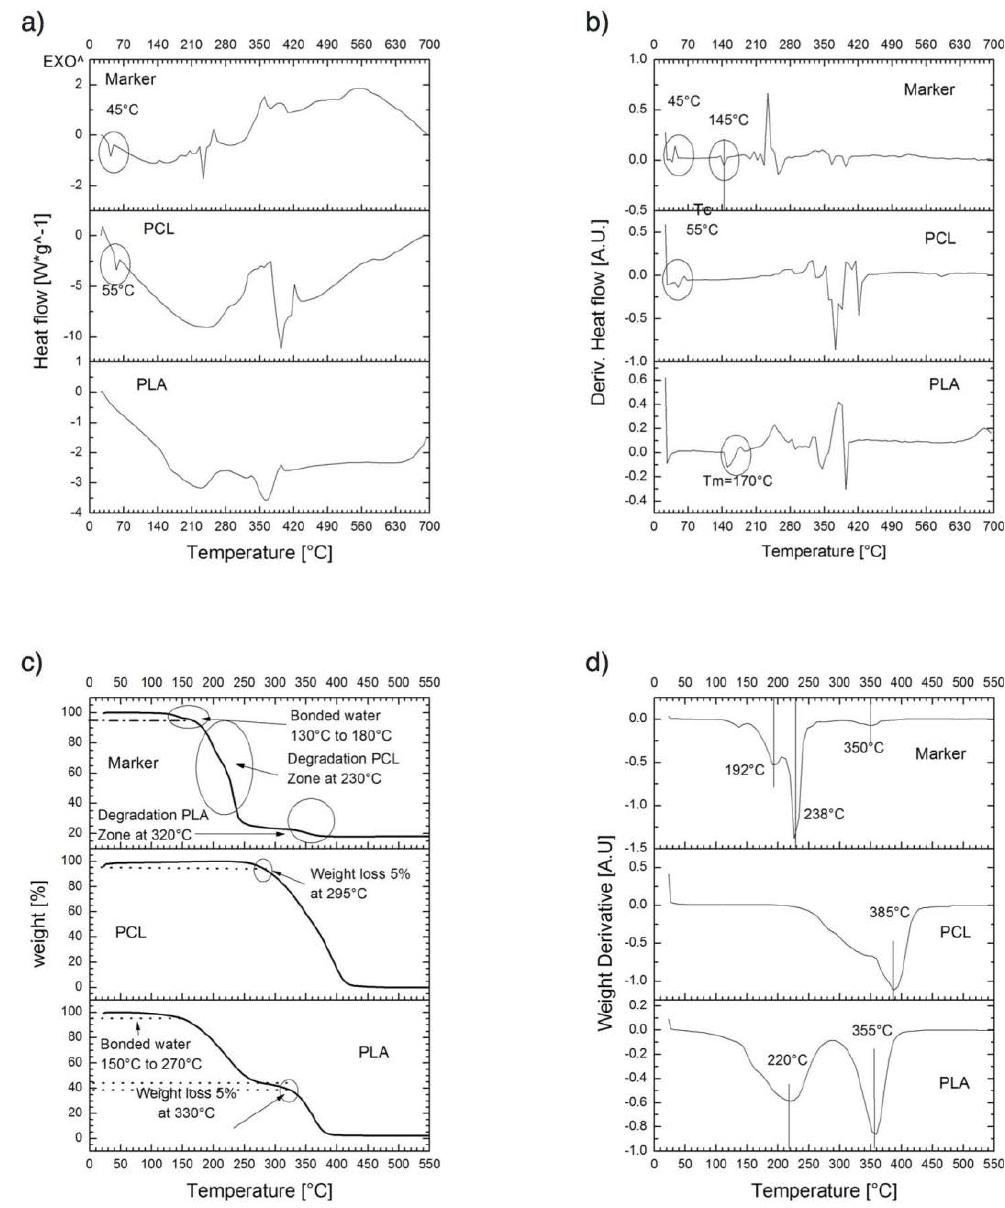
Figure 5. Thermal degradation properties for PLA, PCL, and composite marker: ( a ) thermogravimetric analysis (TGA), ( b ) thermogravimetric derivative (DTG) and thermal curves, ( c ) differential scanning calorimetry (DSC) heating curves and ( d ) first derivative curve of DSC curve.